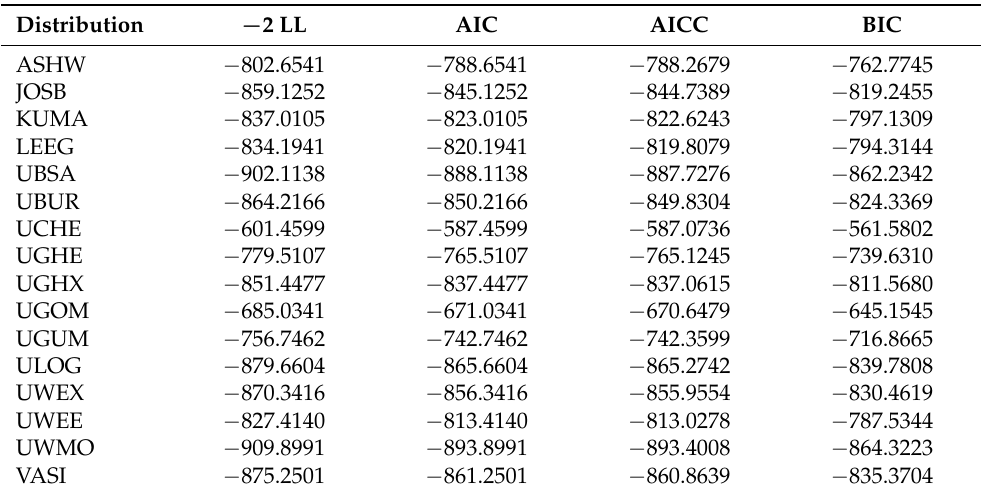
Table 18. Values of the indicated likelihood-based statistic and distribution for τ = 0.25 with data related to fat percentage at the body.